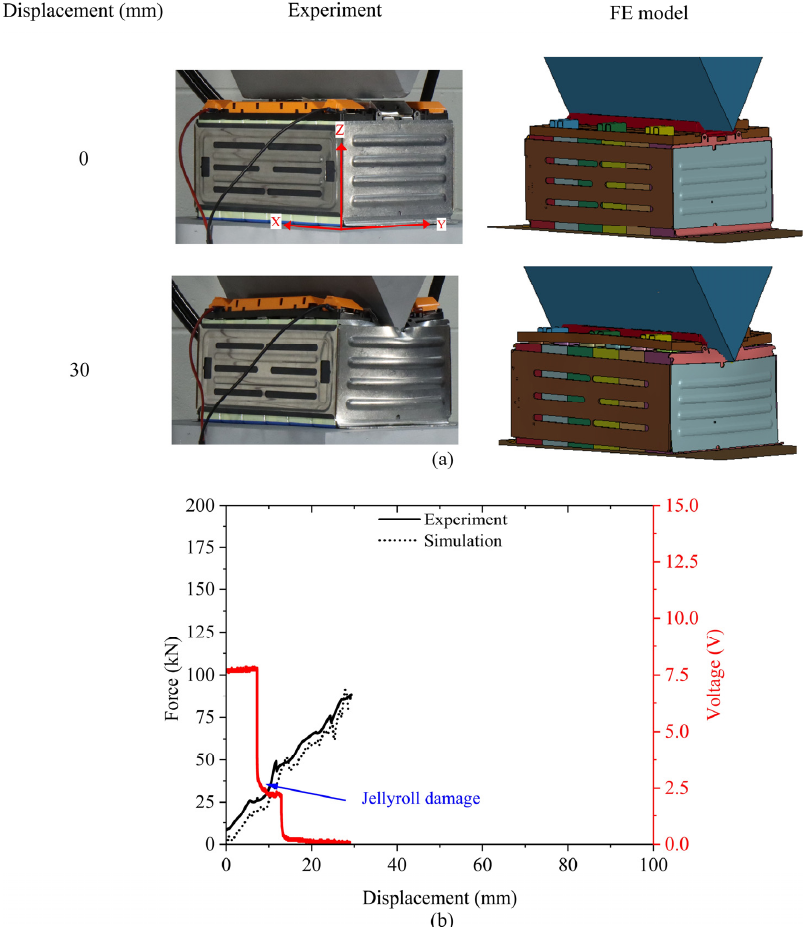
Figure 6. Experimental and FE model simulation for Case 3 (0.05 mm/s quasi-static indentation of battery module along z direction with wedge edge parallel to x direction): ( a ) Module deformations; ( b ) Force-displacement responses (black) and experimental voltage responses (red). ( b ) Force-displacement responses (black) and experimental voltage responses